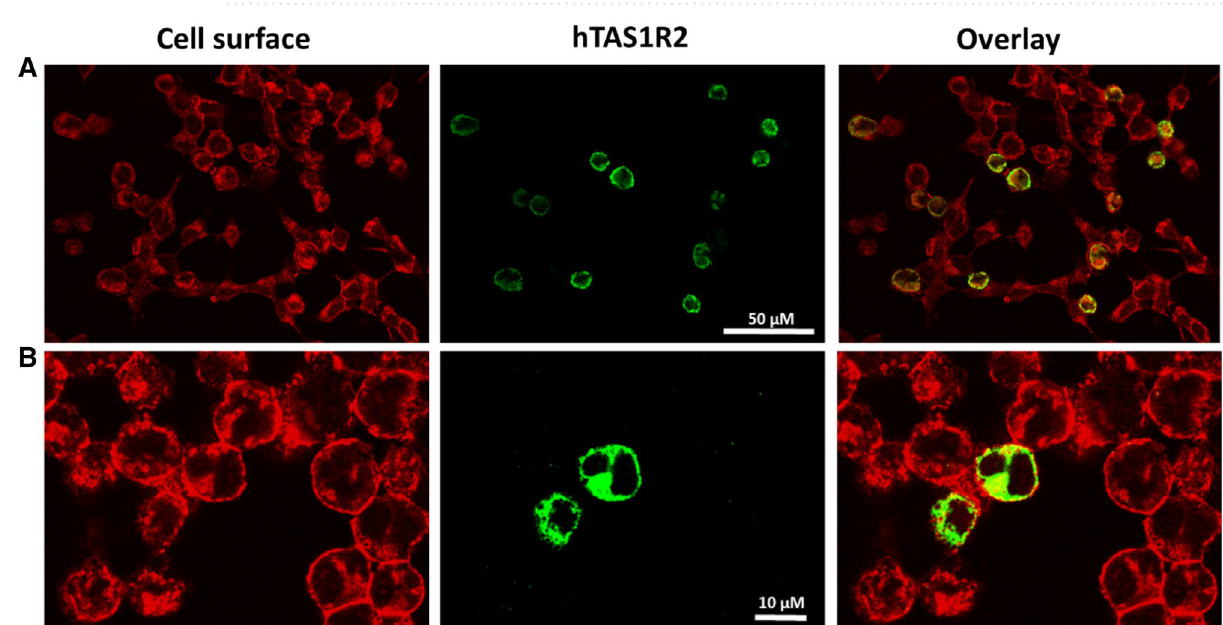
Figure 1. Immunoblot analysis of HEK293S-GnTI- clones stably transfected with pcDNA5/TO-FLAG- hTAS1R2. Each clone was tested for induction with tetracycline alone (1 µg/mL) or in combination with 5 mM NaBu. Three microliters of solubilized protein from cell lysates (3 µg) were loaded onto PVDF membranes, analysed using the dot blot technique and probed with monoclonal FLAG antibody. The results were quantified using Image Lab (Bio-Rad) and normalized to 100% relative intensity. T: tetracycline induction; TB: tetracycline and NaBu induction. Dot blot image is presented in Supplementary Fig. S1.